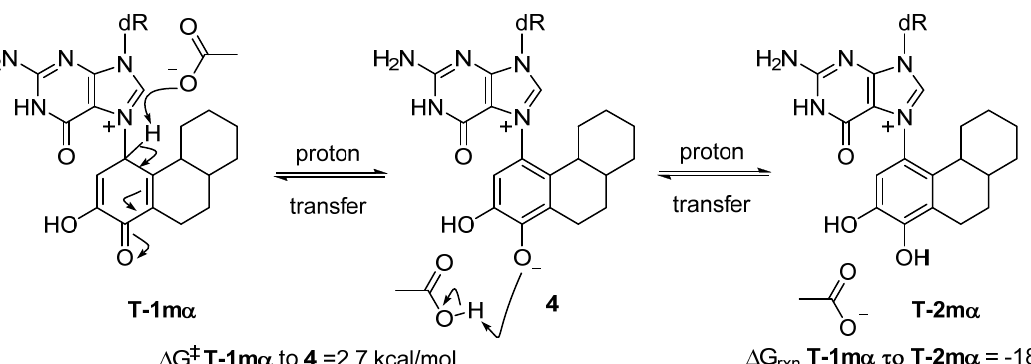
Figure 5. Modeling the kinetics of proton transfer at C1.